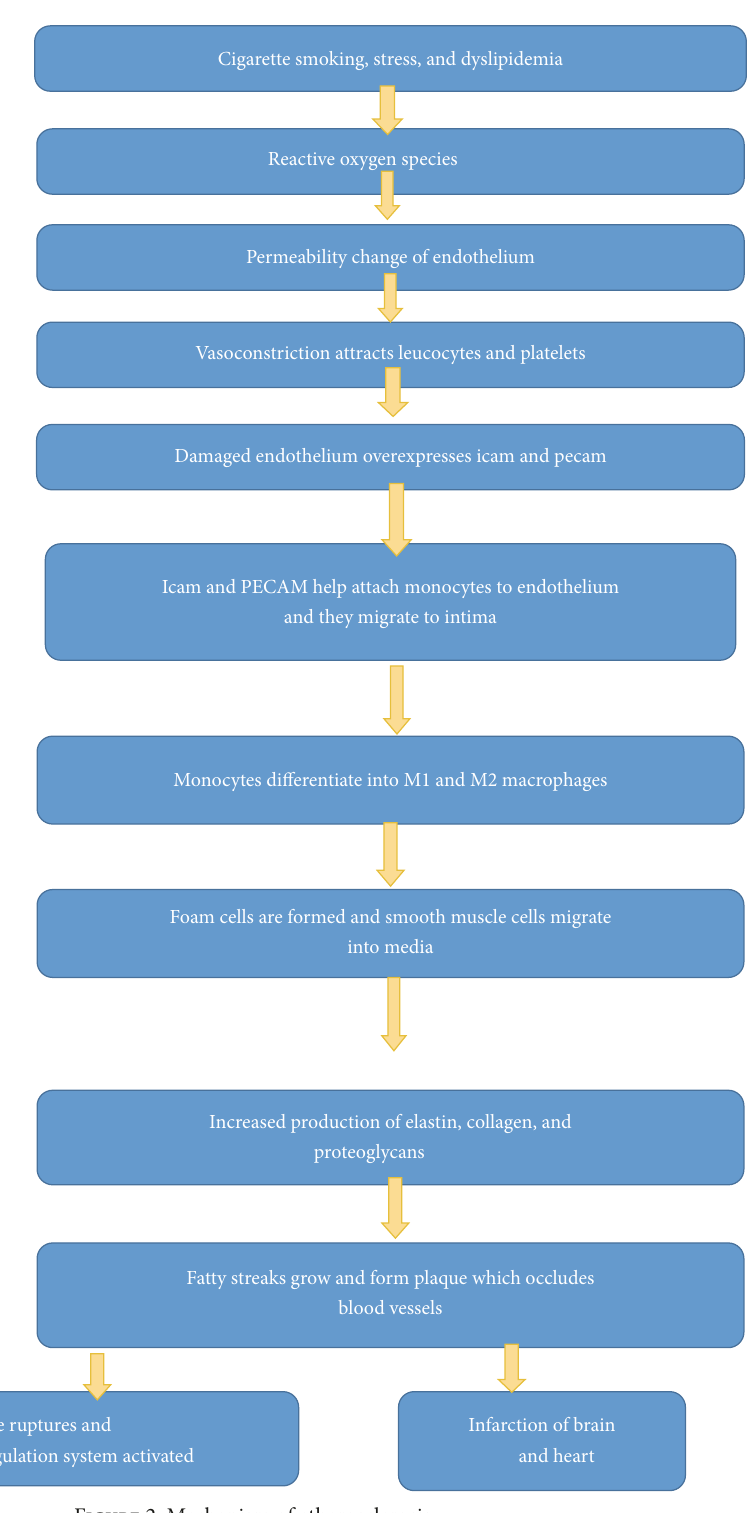
Figure 2: Mechanism of